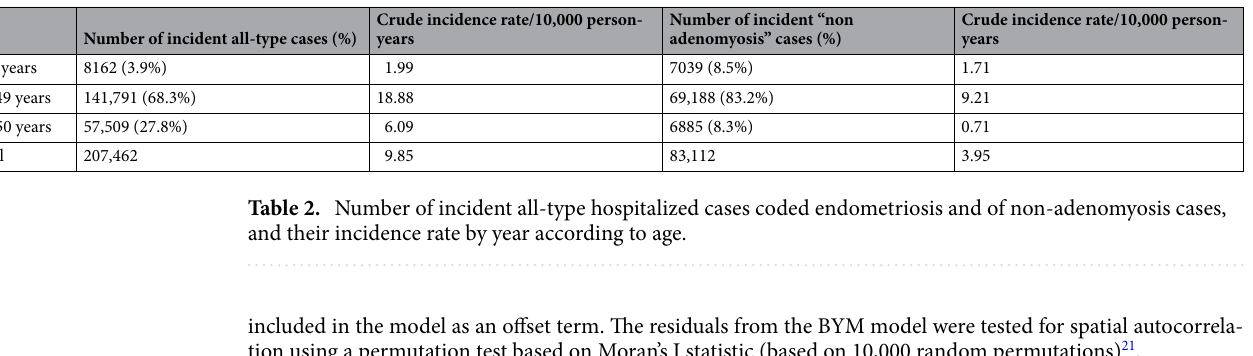
Crude incidence rate/10,000 person-